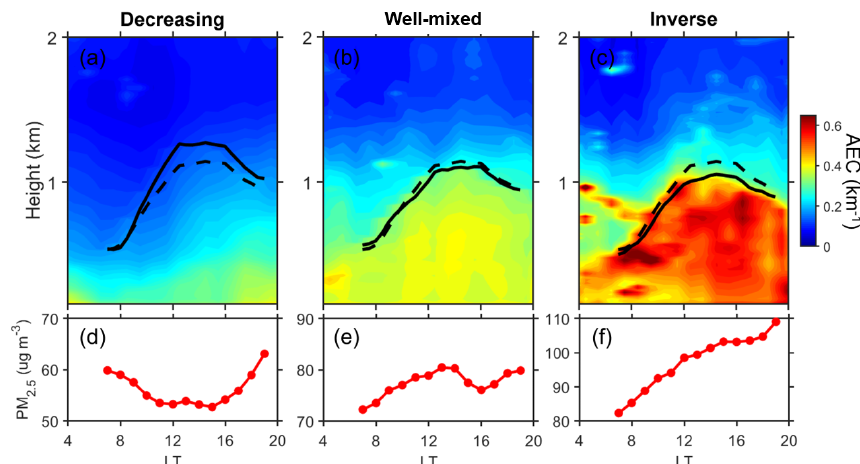
Figure 6. The averaged diurnal variations in AEC for (a) decreasing, (b) well-mixed, and (c) increasing (i.e., inverse) aerosol structures. Solid black lines indicate the averaged diurnal cycles of MPL-derived PBLH under the different aerosol structures. Dashed black lines represent the mean MPL-derived PBLH diurnal cycles. (d, e, f) The averaged diurnal variations in surface PM 2 . 5 under the different aerosol structures.